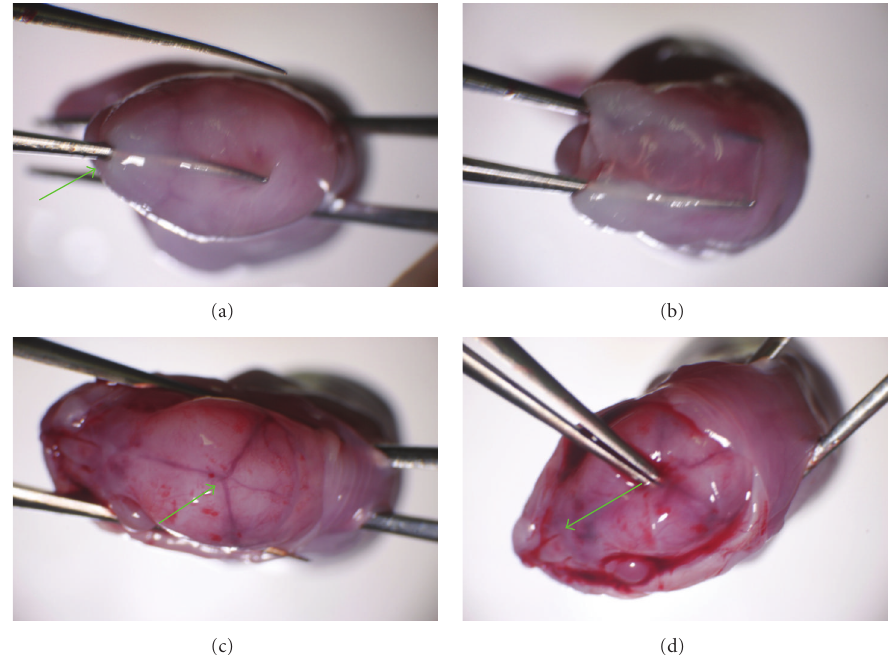
Figure 2: (a) Traditional approach, (b) modified approach, (c) craniotomy point and (d) dissection of skull and cerebral dura mater.